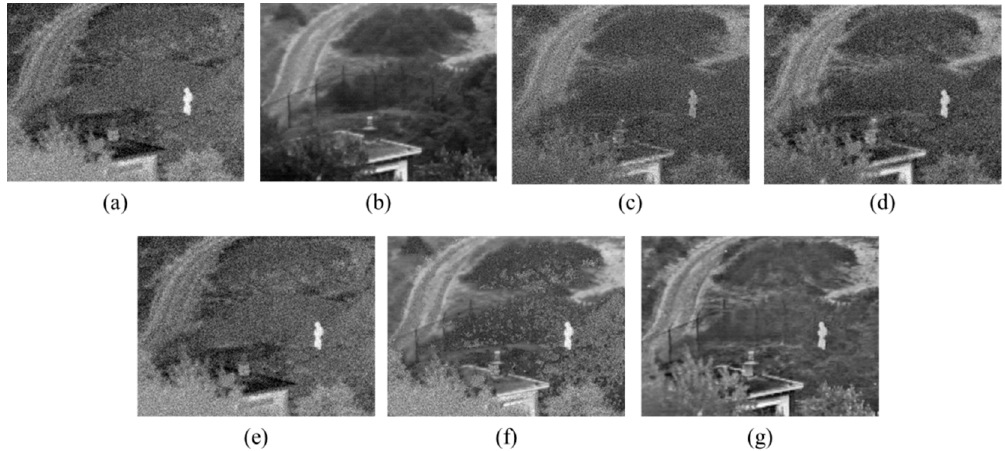
Figure 9. Noisy UNCamp noise-adding image fusion comparisons: ( a ) IR image; ( b ) Visible image; ( c